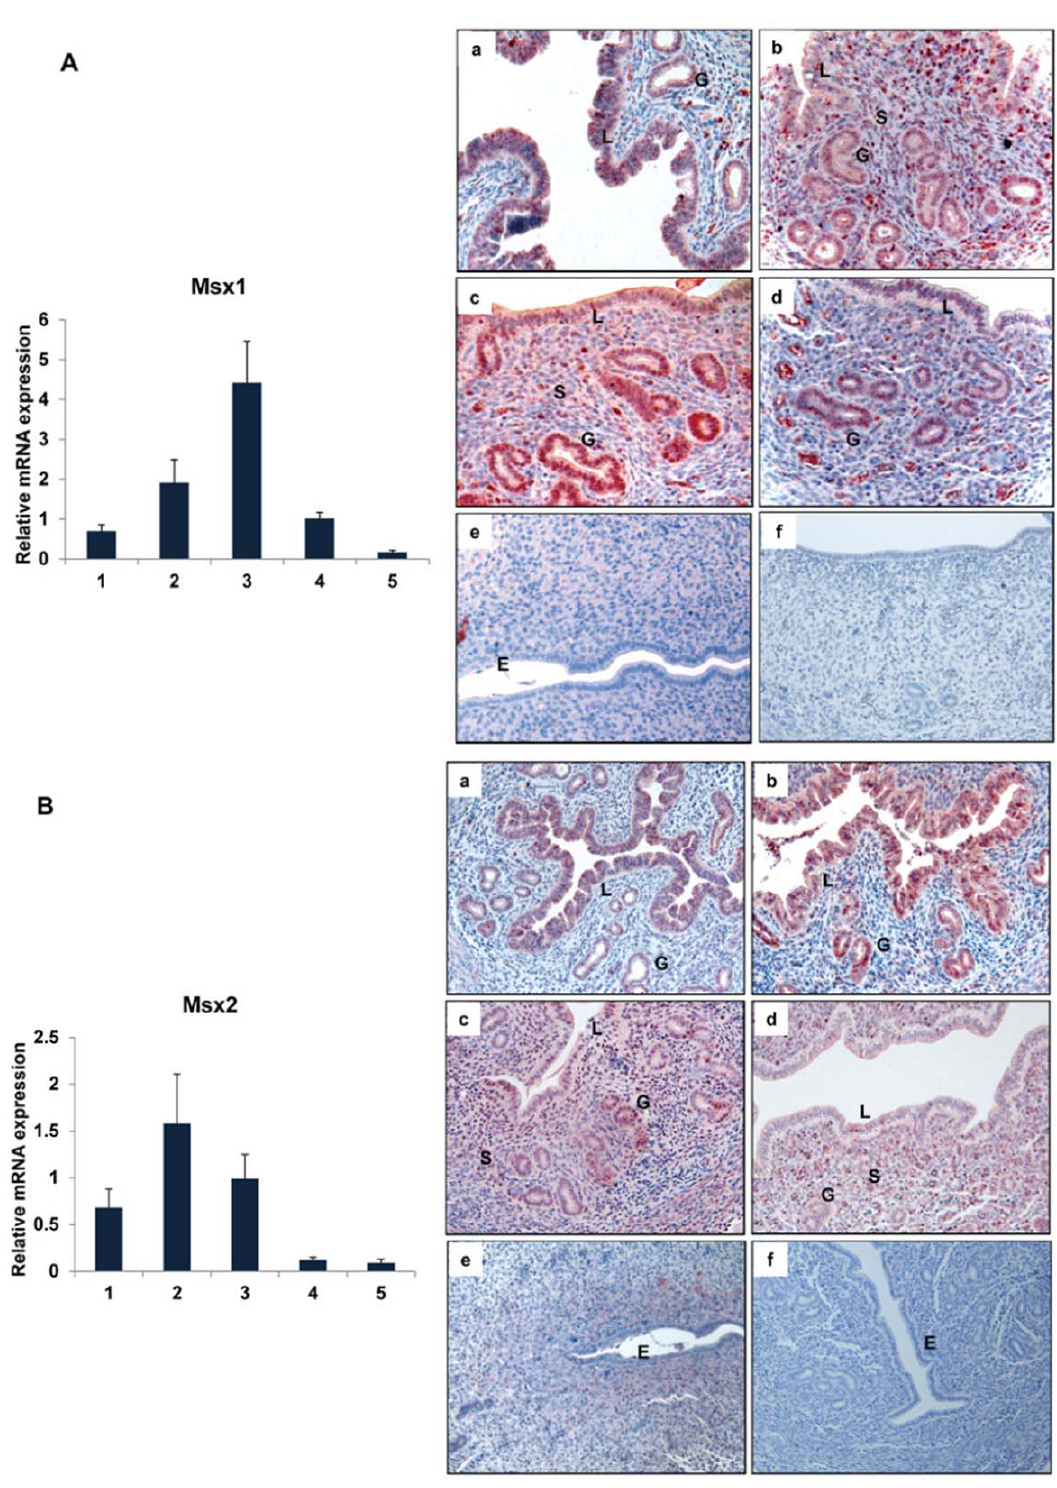
Figure 1. Expression of Msx 1 and Msx 2 in the uterus during early pregnancy. Real-time PCR was performed to monitor the expression of mRNAs corresponding to Msx1 and Msx2 in uterus on days 1 to 5 of gestation. The relative levels of gene expression on different days of pregnancy were determined by setting the expression level of Msx1 mRNA (A, Left panel) and Msx2 mRNA (B, Left panel) on day 1 of pregnancy at 1.0. Rplp0 , encoding a ribosomal protein, was used to normalize the level of RNA. Uterine sections from day 1 to day 5 (a–e) of pregnancy were subjected to immunohistochemical analysis using anti-MSX1 (A, Right panel) and anti-MSX2 (B, Right panel) antibodies. Panel f shows uterine sections from day 3 pregnant mice treated with non-immune IgG. L, G and S indicate luminal epithelium, glandular epithelium and stroma, respectively.